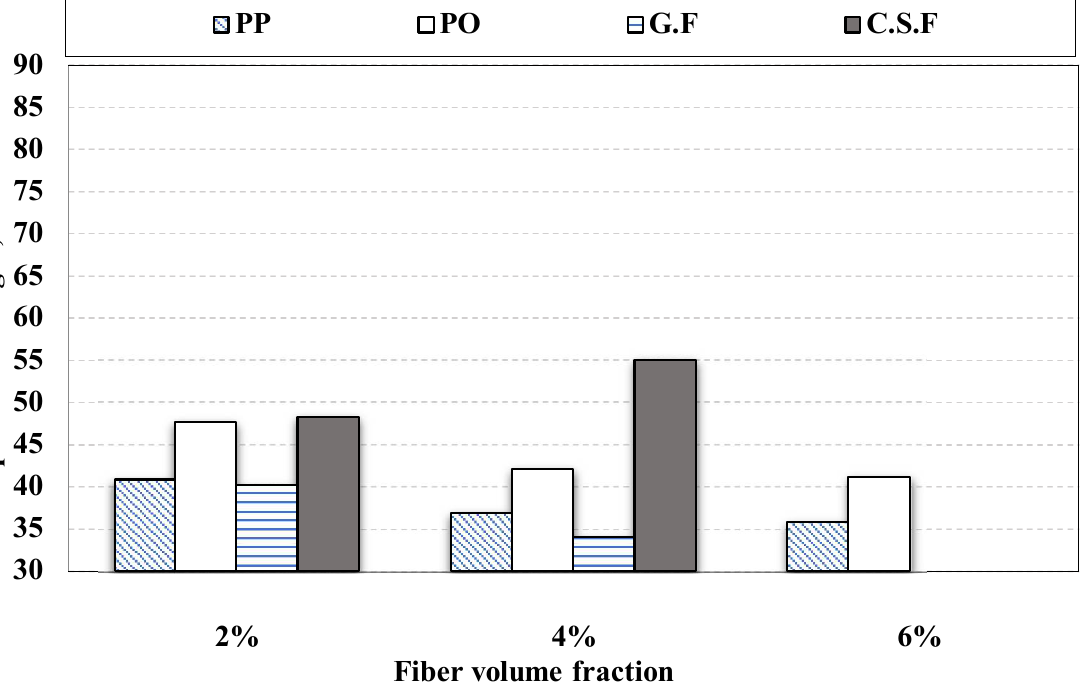
Figure 8. Compressive strength at 7 days due to fiber type change.